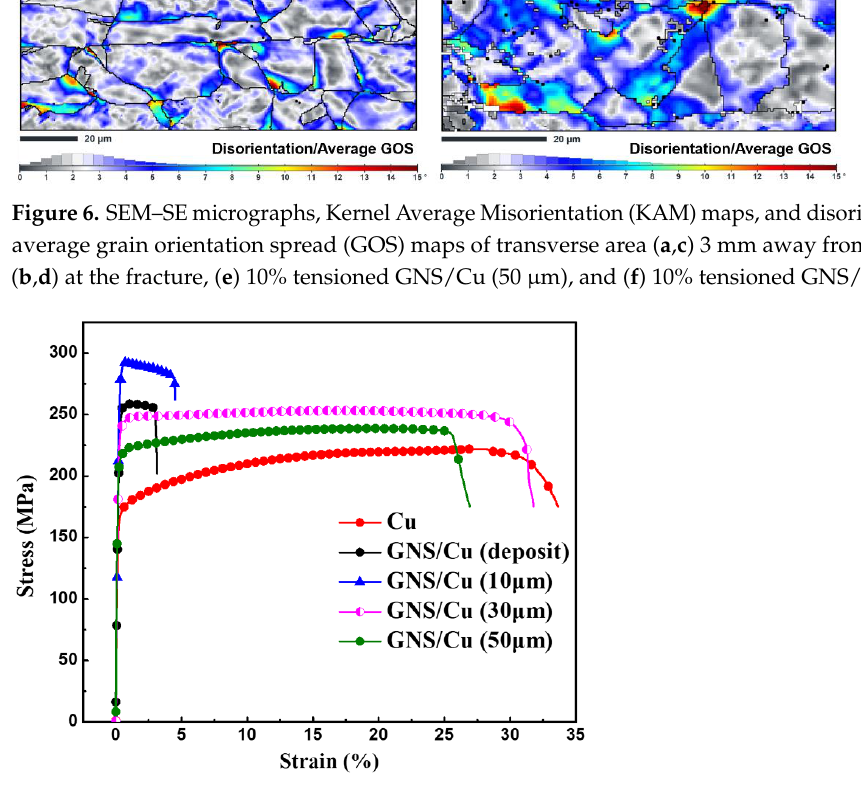
Figure 7. Room-temperature engineering strain – stress curves of pure Cu and GNS/Cu composites with various Cu layer thicknesses.